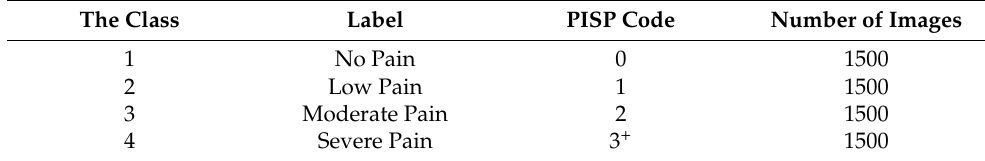
Table 1. Our subset data description.